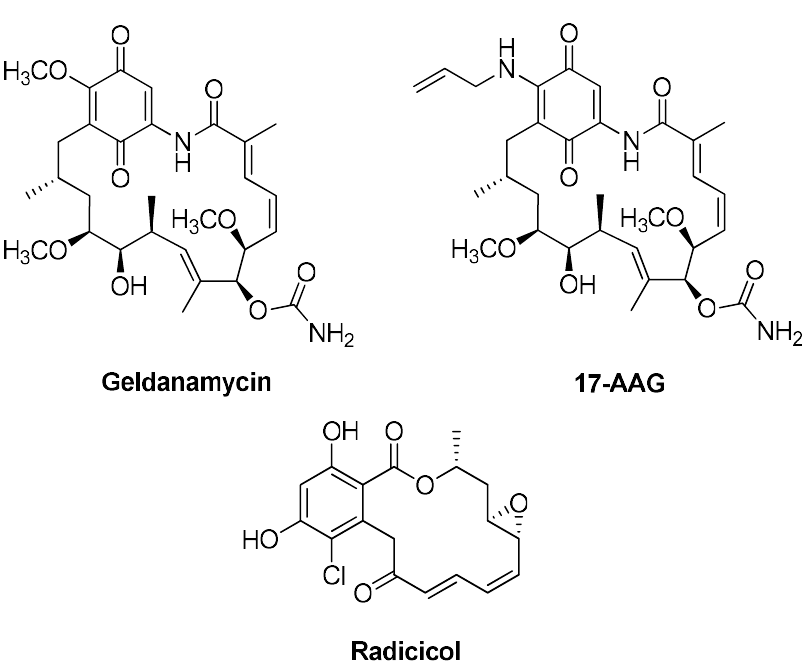
Figure 8. Chemical structures of Hsp90 inhibitors targeting the ATP binding site.